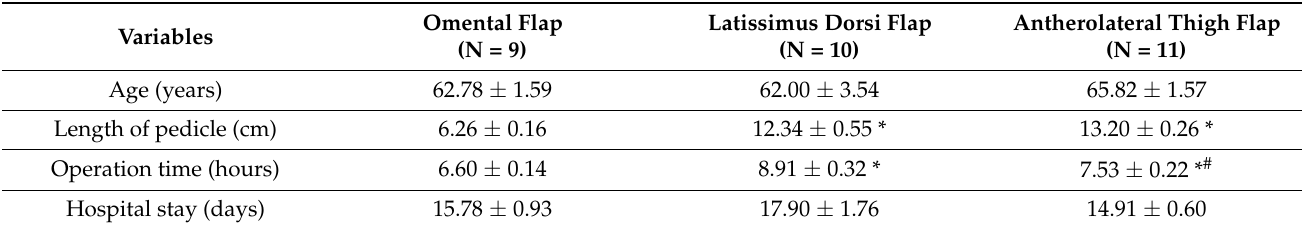
Table 3. Results represented as mean ± SEM. * p < 0.05 respect to omental flap group. # p < 0.05 respect to latissimus dorsi flap